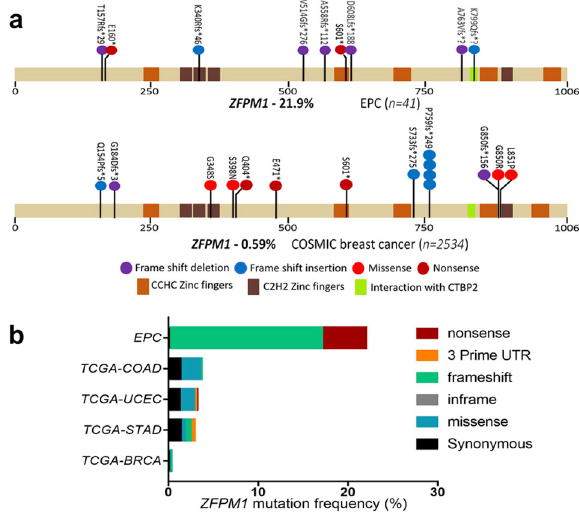
Fig. 5 Mapping of mutation sites in ZFPM1 from our series and the COSMIC dataset. a The functional domains of the altered proteins were identi fi ed based on the UniProt database. The upper bar depicted ZFPM1 mutations in EPCs by TS ( n = 41). The bar below showed ZFPM1 mutations in breast cancers from the COSMIC dataset. b ZFPM1 mutation frequency in EPCs compared to that in several TCGA projects. COAD, colon adenocarcinoma (17/461, 3.68%); STAD, stomach adenocarcinoma (13/447, 2.90%); UCEC, uterine corpus endometrial carcinoma (18/560, 3.21%); BRCA, invasive breast carcinoma (3/986, 0.30%).